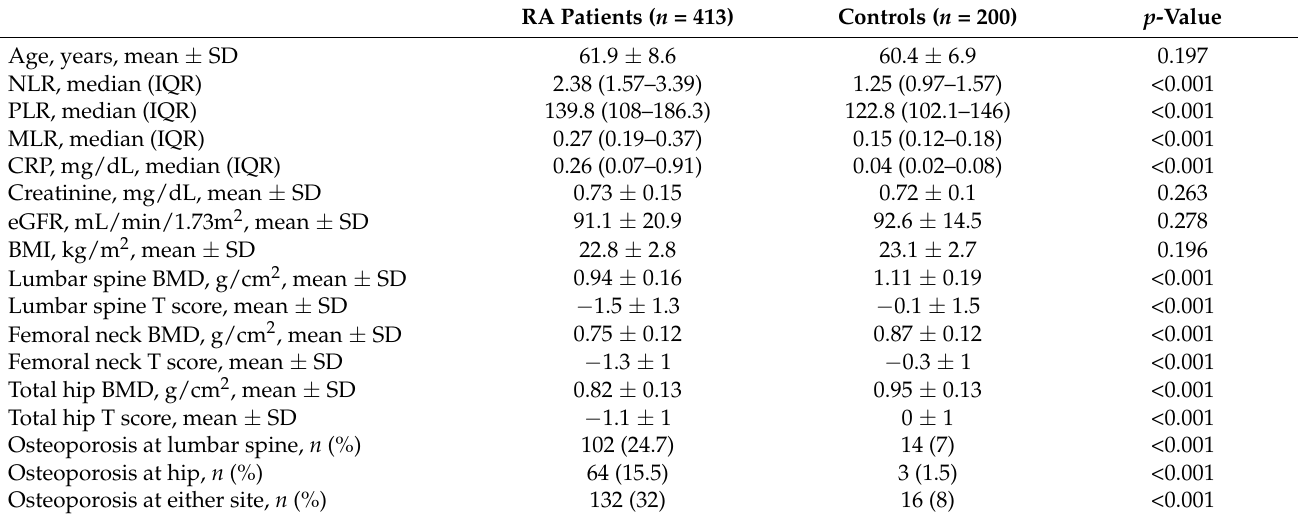
Table 1. Comparisons of clinical and laboratory data between postmenopausal women with rheuma- toid arthritis and healthy